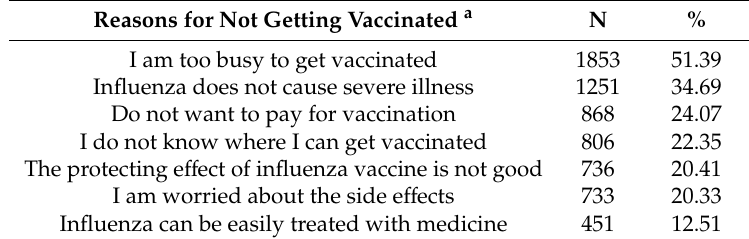
Table 5. Reasons for Influenza vaccination non-receipt-Internet panel survey, China, 2018–2019 season (N =